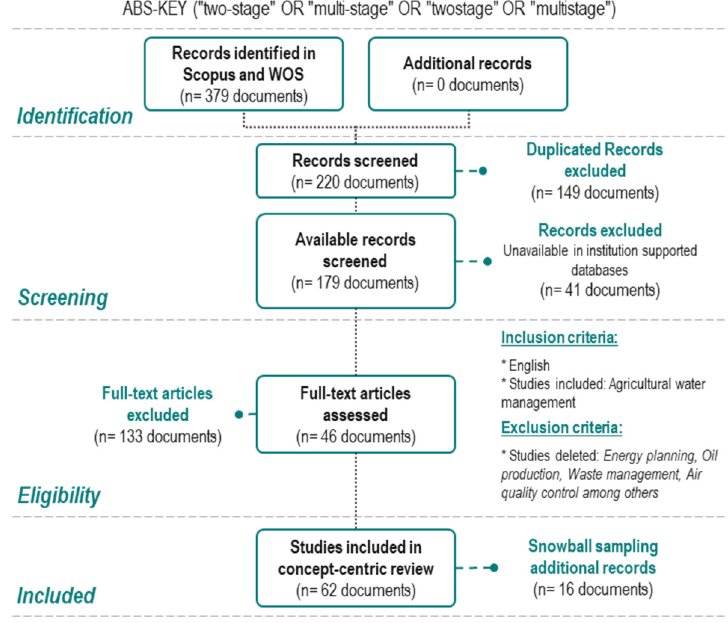
Figure 1. Search equation and flow chart for article extraction.